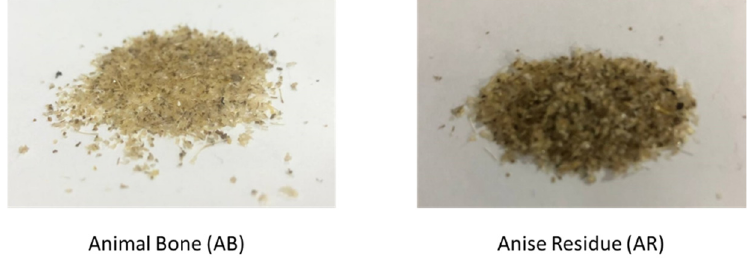
Figure 1. Visual representation of the adsorbent materials used: animal bone (AB) and anise residue (AR).